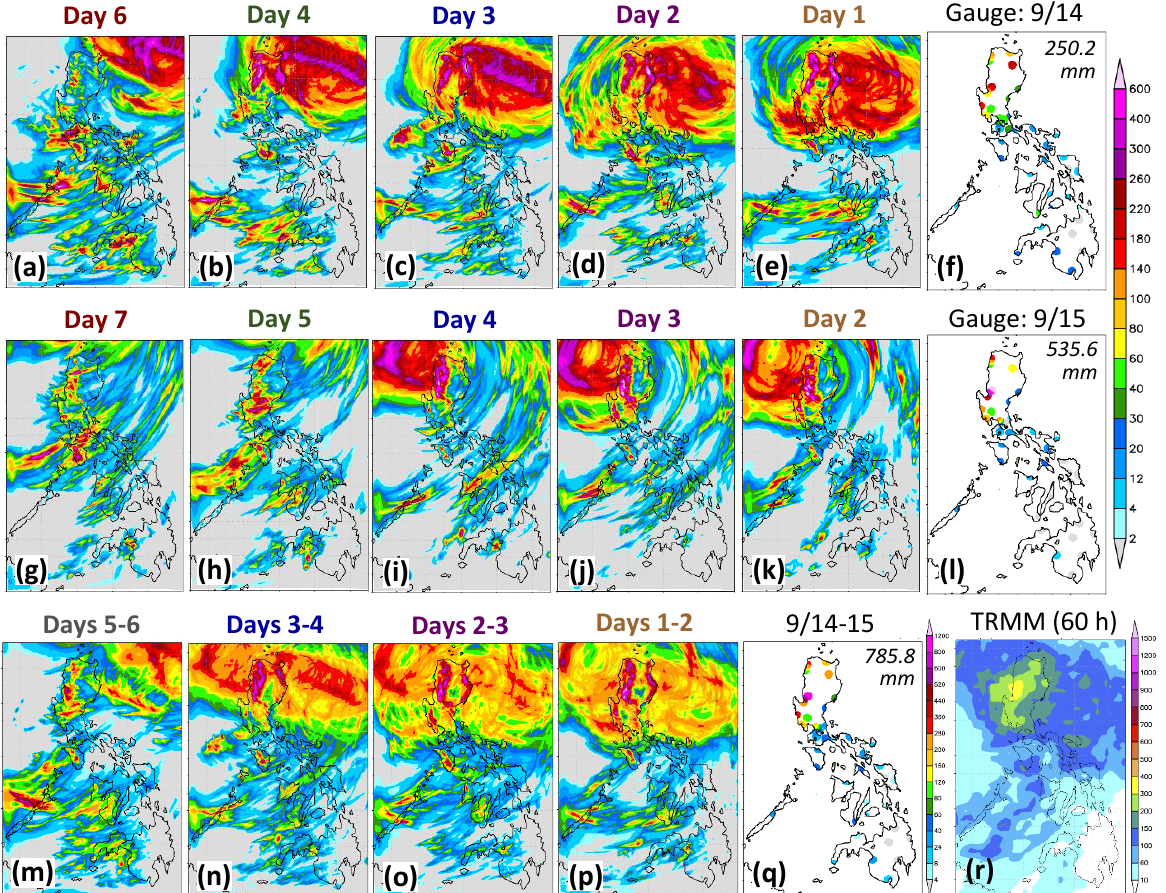
Figure 4. Predicted distributions of the 24 h daily total rainfall (mm, scale to the right) at ( a – e ) five different ranges (as labeled) for 14 September and ( f ) the corresponding gauge observations during TY Mangkhut (2018). ( g – l ) As in ( a – f ), except for 15 September 2018. ( m – q ) As in ( a – f ), except for 48 h QPFs over 14 – 15 September (in UTC) at ( m – p ) four different ranges and ( q ) from the gauge data. In the headings of model predictions, the same colors as in Figure 2a (for t 0 ) are used. ( r ) TRMM total rainfall (mm) for the entire typhoon event (60 h starting from 1200 UTC 13 September). The same color scale is used for ( a – l ) and doubled for ( m – q ). Only ( r ) has its own scale.